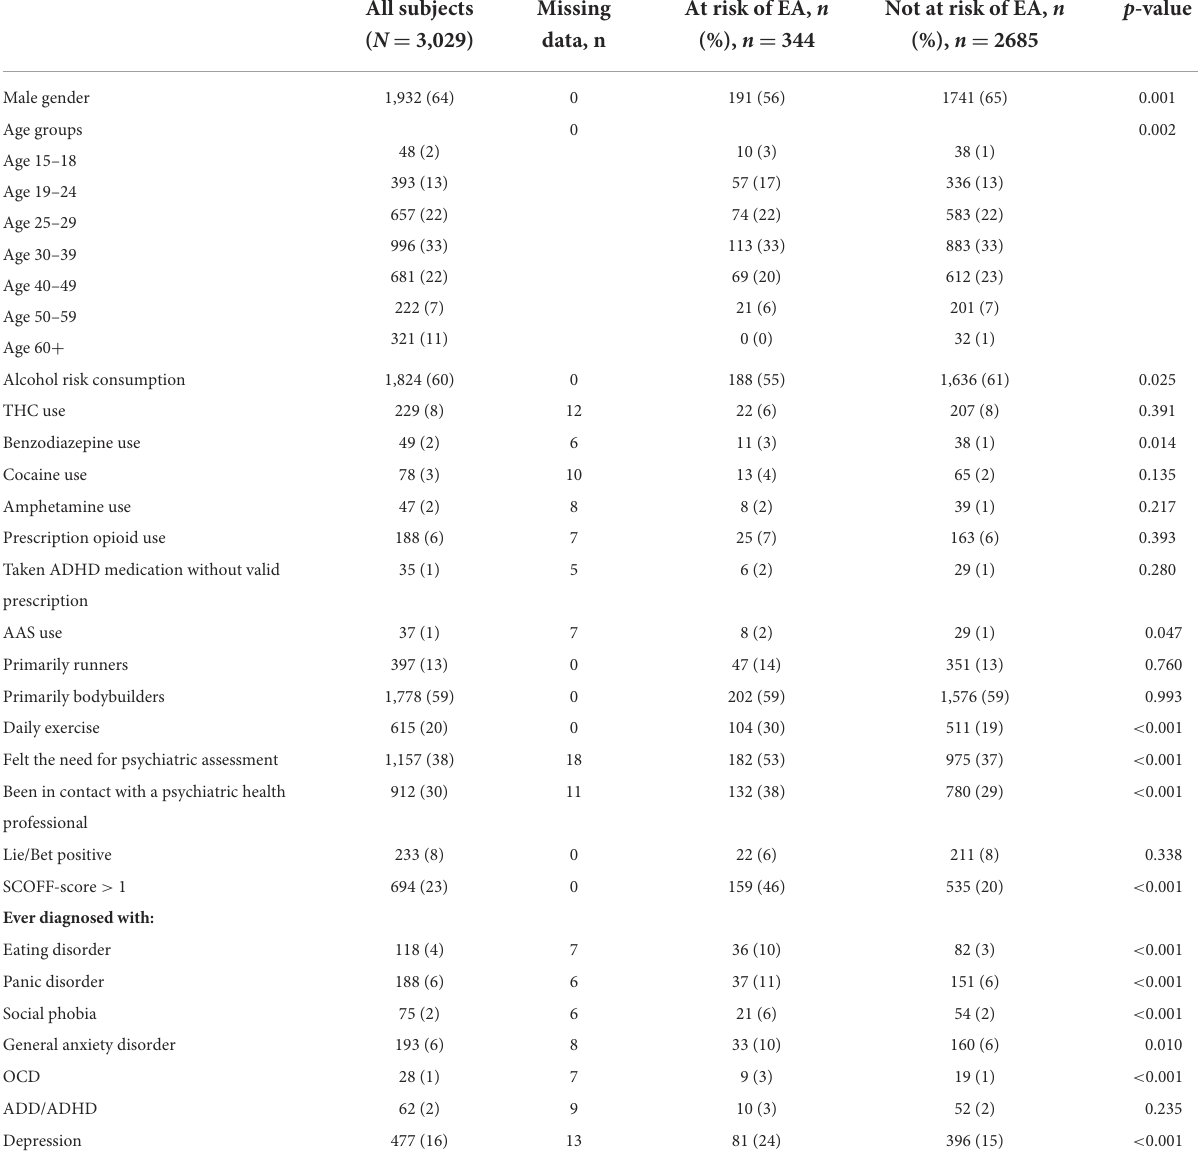
TABLE 1 Descriptive characteristics of 3,029 athletes who exercise more than three times a week comparing those at risk of exercise addiction (EA) to those not at risk based on the exercise addiction inventory >